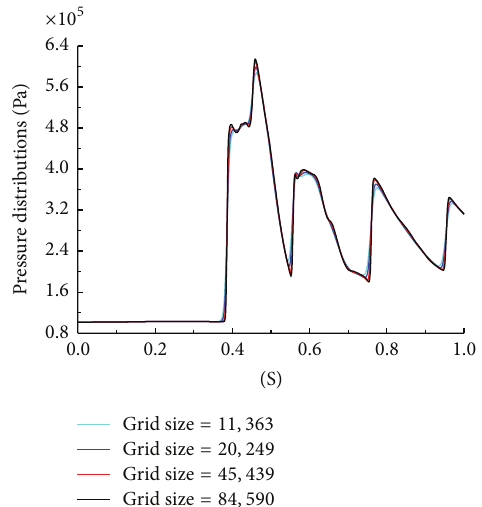
Figure 6: Comparison of pressure distribution of stationary engine case versus normalized streamwise distance in different grid sizes.